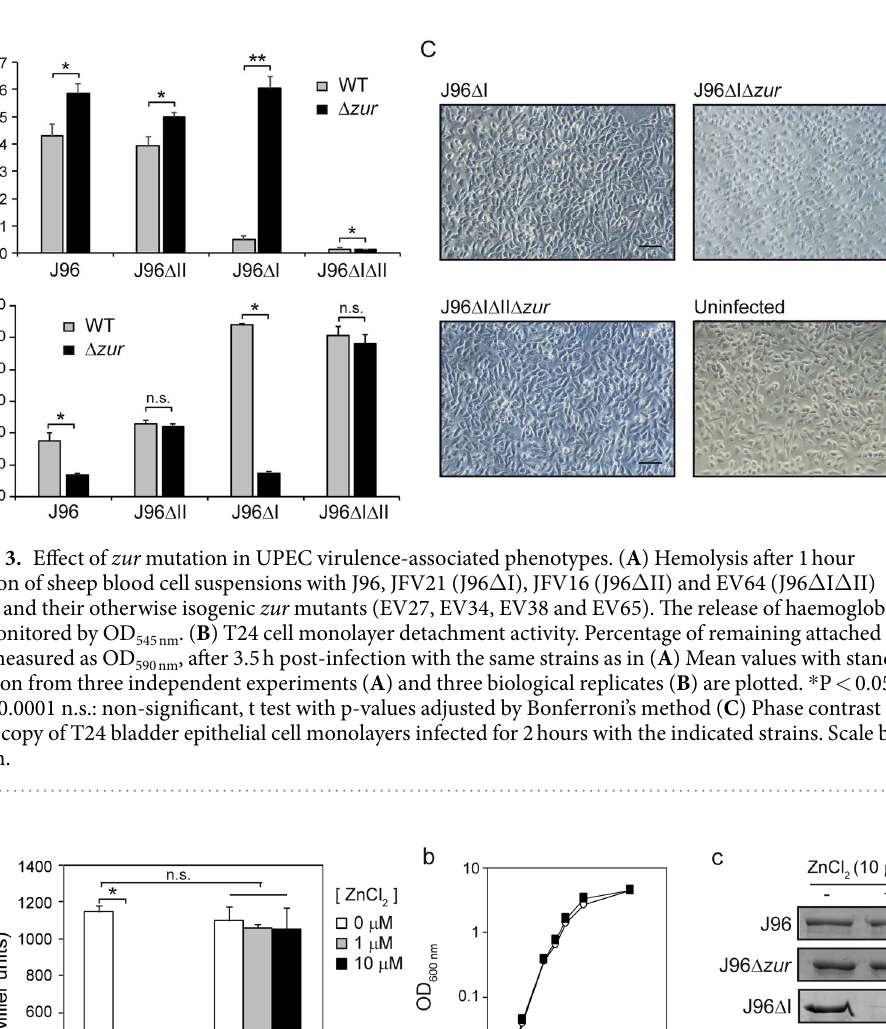
5 SCIeNtIfIC REPORTS | (2018) 8:6535 | DOI:10.1038/s41598-018-24964-1